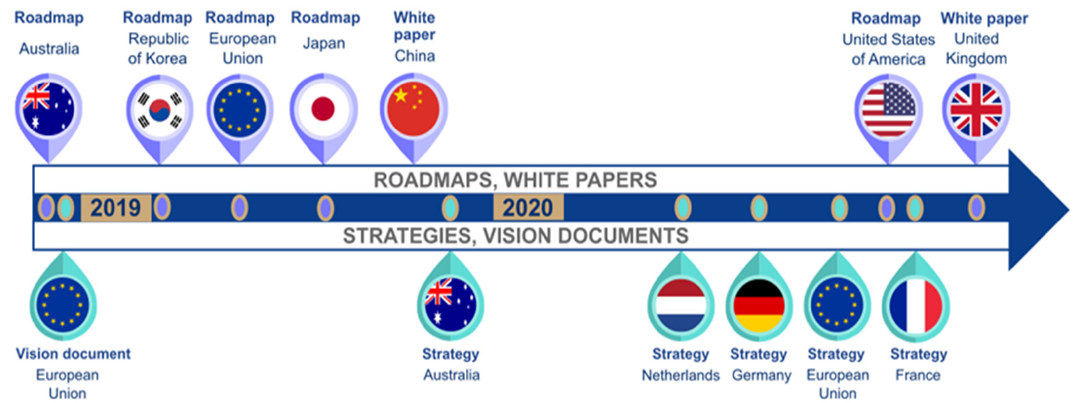
Figure 1. The latest hydrogen-related government documents cited in this paper.